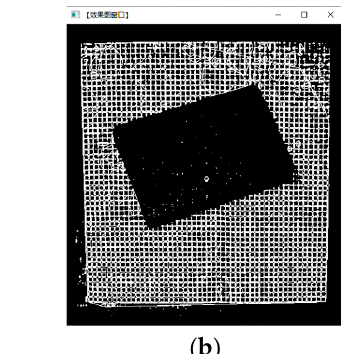
Table 1. Di ff erent types of parking spaces.